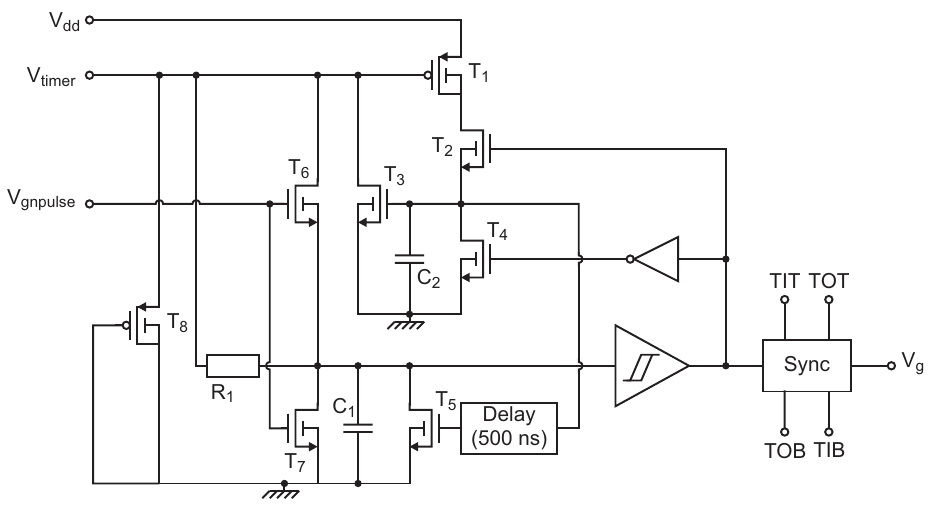
Figure 6. Schematic of the timer